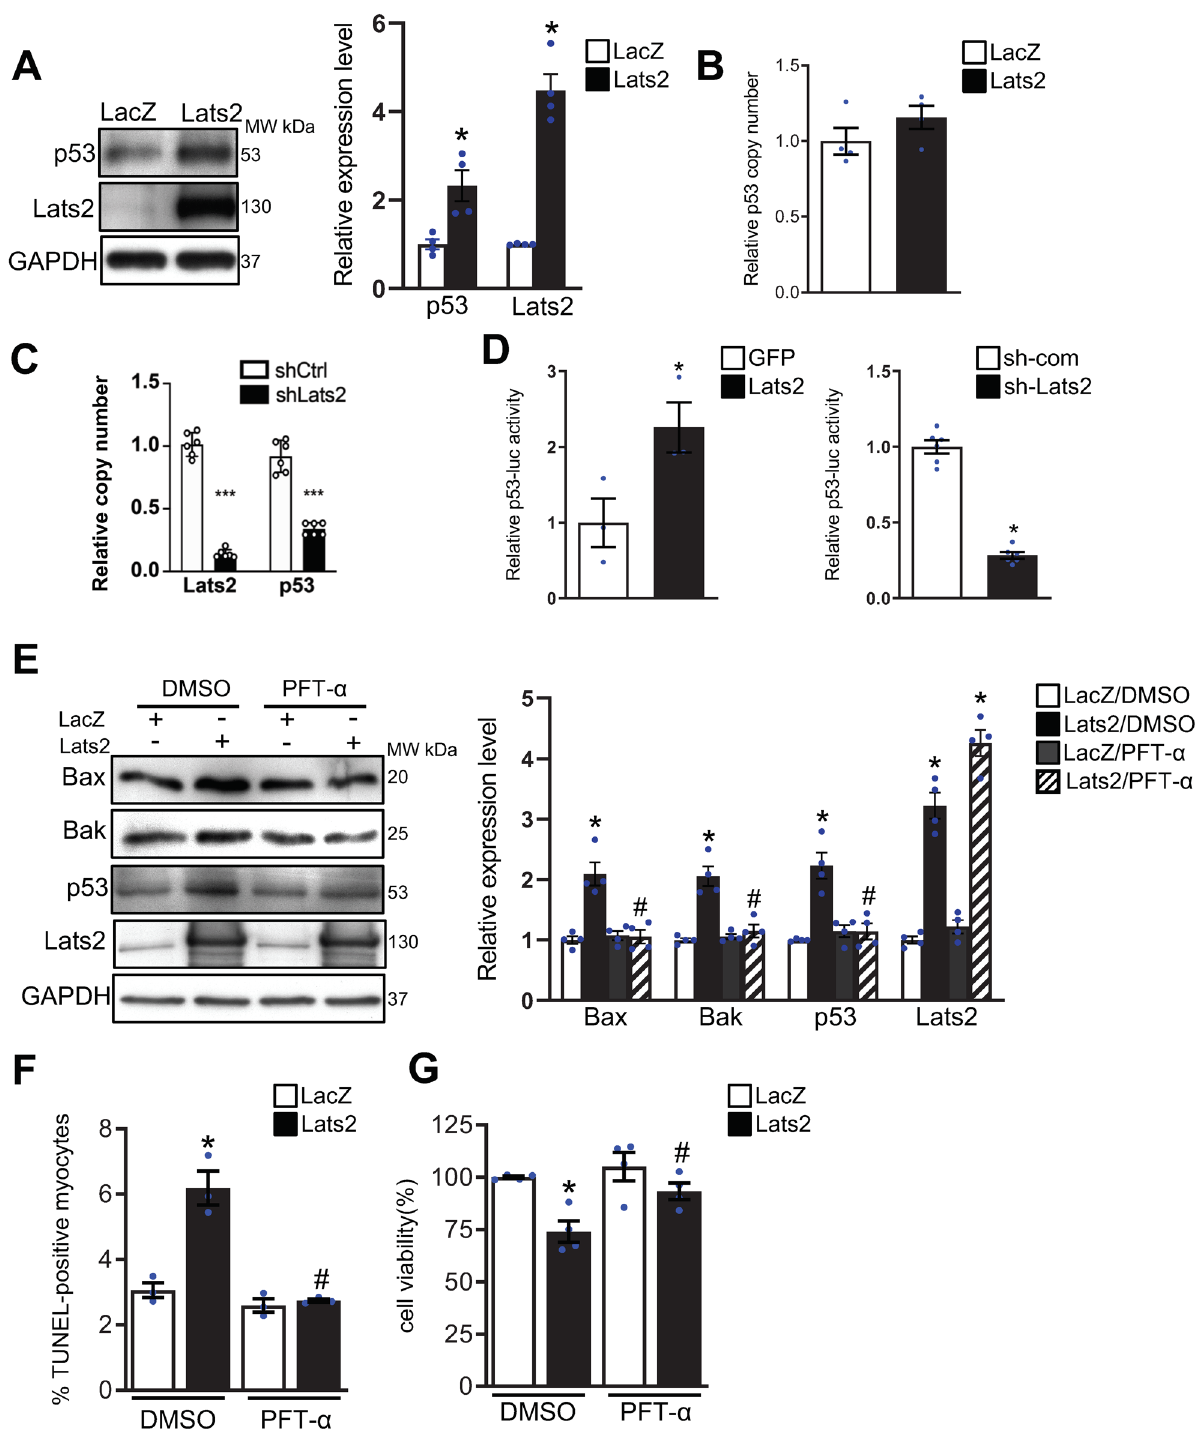
Figure 6. Lats2 upregulates Bax and Bak in a p53-dependent manner. ( A ) and ( B ), Cultured neonatal rat ventricular cardiomyocytes were transduced with adenovirus harboring either LacZ or Lats2. ( A ), Protein levels of p53, Lats2 and GAPDH were evaluated with immunoblot analyses. ( B ), mRNA levels of p53 were evaluated with qPCR analyses. ( C ), Cultured neonatal rat ventricular cardiomyocytes were transduced with adenovirus harboring either shRNA Lats2 or shRNA control. mRNA levels of p53 were evaluated with qPCR analyses. *** p < 0.001 versus Adenovirus harboring shRNA control. (n = 6). ( D ), Cultured neonatal rat ventricular cardiomyocytes were transfected with p53-luciferase reporter together with expression plasmids harboring either GFP (control) or Lats2 (left) and either shRNA-control or shRNA-Lats2. Relative luciferase activity is shown. The level of reporter gene activity in control (GFP or shRNA control) transfected cells was designated as 1. ( E – G ), Cultured neonatal rat ventricular cardiomyocytes were transduced with adenovirus harboring LacZ or Lats2 in the presence of Pifithrin-α (PFT-α), a p53 inhibitor, or dimethylsulfoxide (DMSO), a vehicle. ( E ), The levels of Bax, Bak, p53, Lats2 and GAPDH in cardiomyocytes were evaluated with immunoblot analyses. Representative images of immunoblot analyses are shown. Experiments were repeated three times. ( F ), Cardiomyocyte apoptosis was evaluated with TUNEL assays. ( G ), Cell viability was evaluated with CellTiter-Blue assays. In ( B ) and ( C ), * p < 0.05 versus LacZ- transduced cardiomyocytes in the presence of DMSO. # p < 0.05 versus Lats2-transduced cardiomyocytes in the presence of